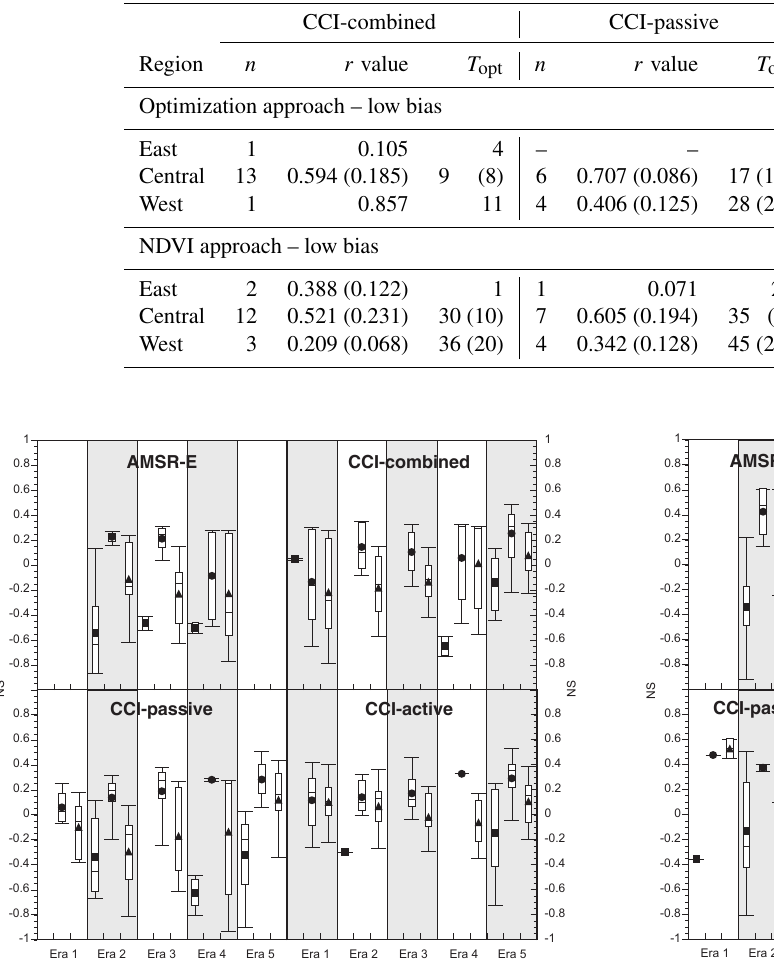
Figure 5. Box plots depicting the NS metric for the SCAN network. Symbols are the same as in Fig.